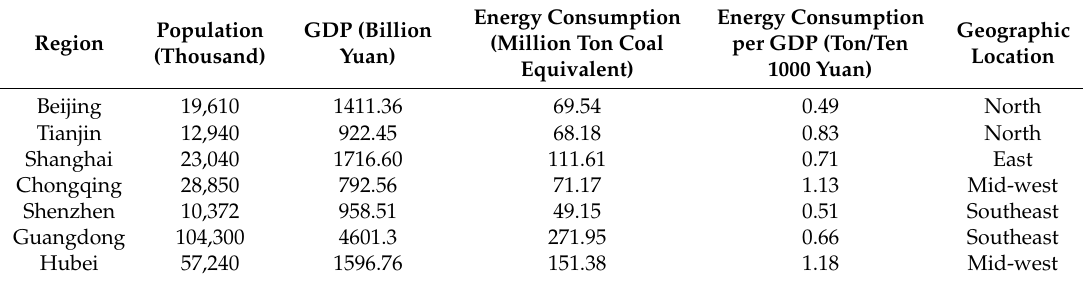
Table 1. General characteristics of pilot regions.